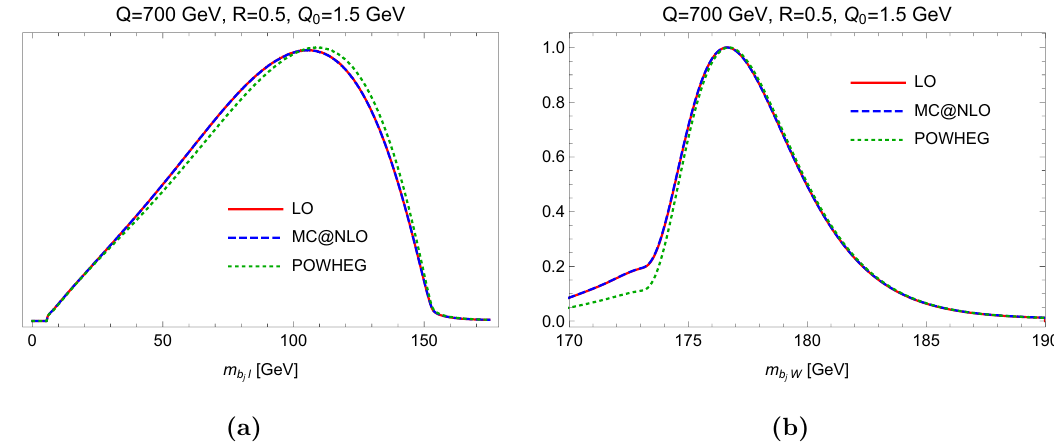
Figure 19. The m b (left panel) and m b distributions (right panel) generated with Herwig 7 j ‘ j W full simulations for m t = 173 GeV for Q = 700 GeV, jet radius R = 0 : 5 and Cambridge-Aachen-type b -jet clustering. Show are results at LO (solid red curves), with MC@NLO-type matching (dashed blue curves) and POWHEG-type matching (dotted green